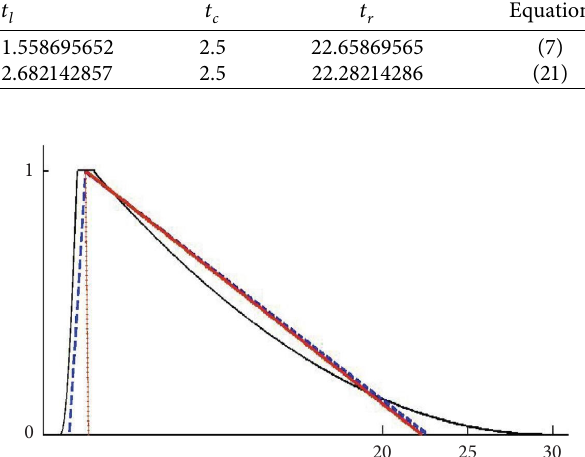
Figure 3: Te best generalized fuzzy quantity for w � 10, solid curve: u ; dashed curve: equation (7); dotted curve: equation (21).